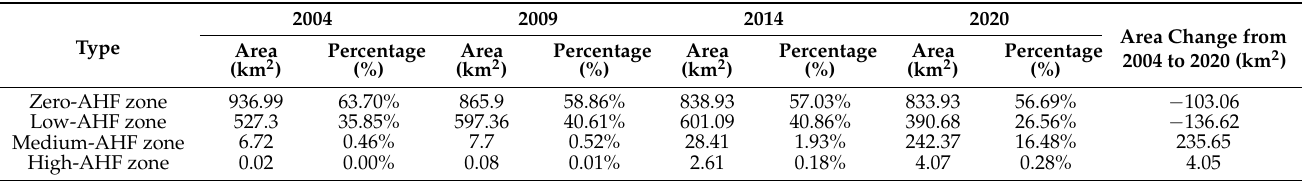
Figure 5. Distribution of anthropogenic heat level types ( a ) in 2004, ( b ) in 2009, ( c ) in 2014, and ( d ) in 2020. Table 6. Statistics of different levels of anthropogenic heat.